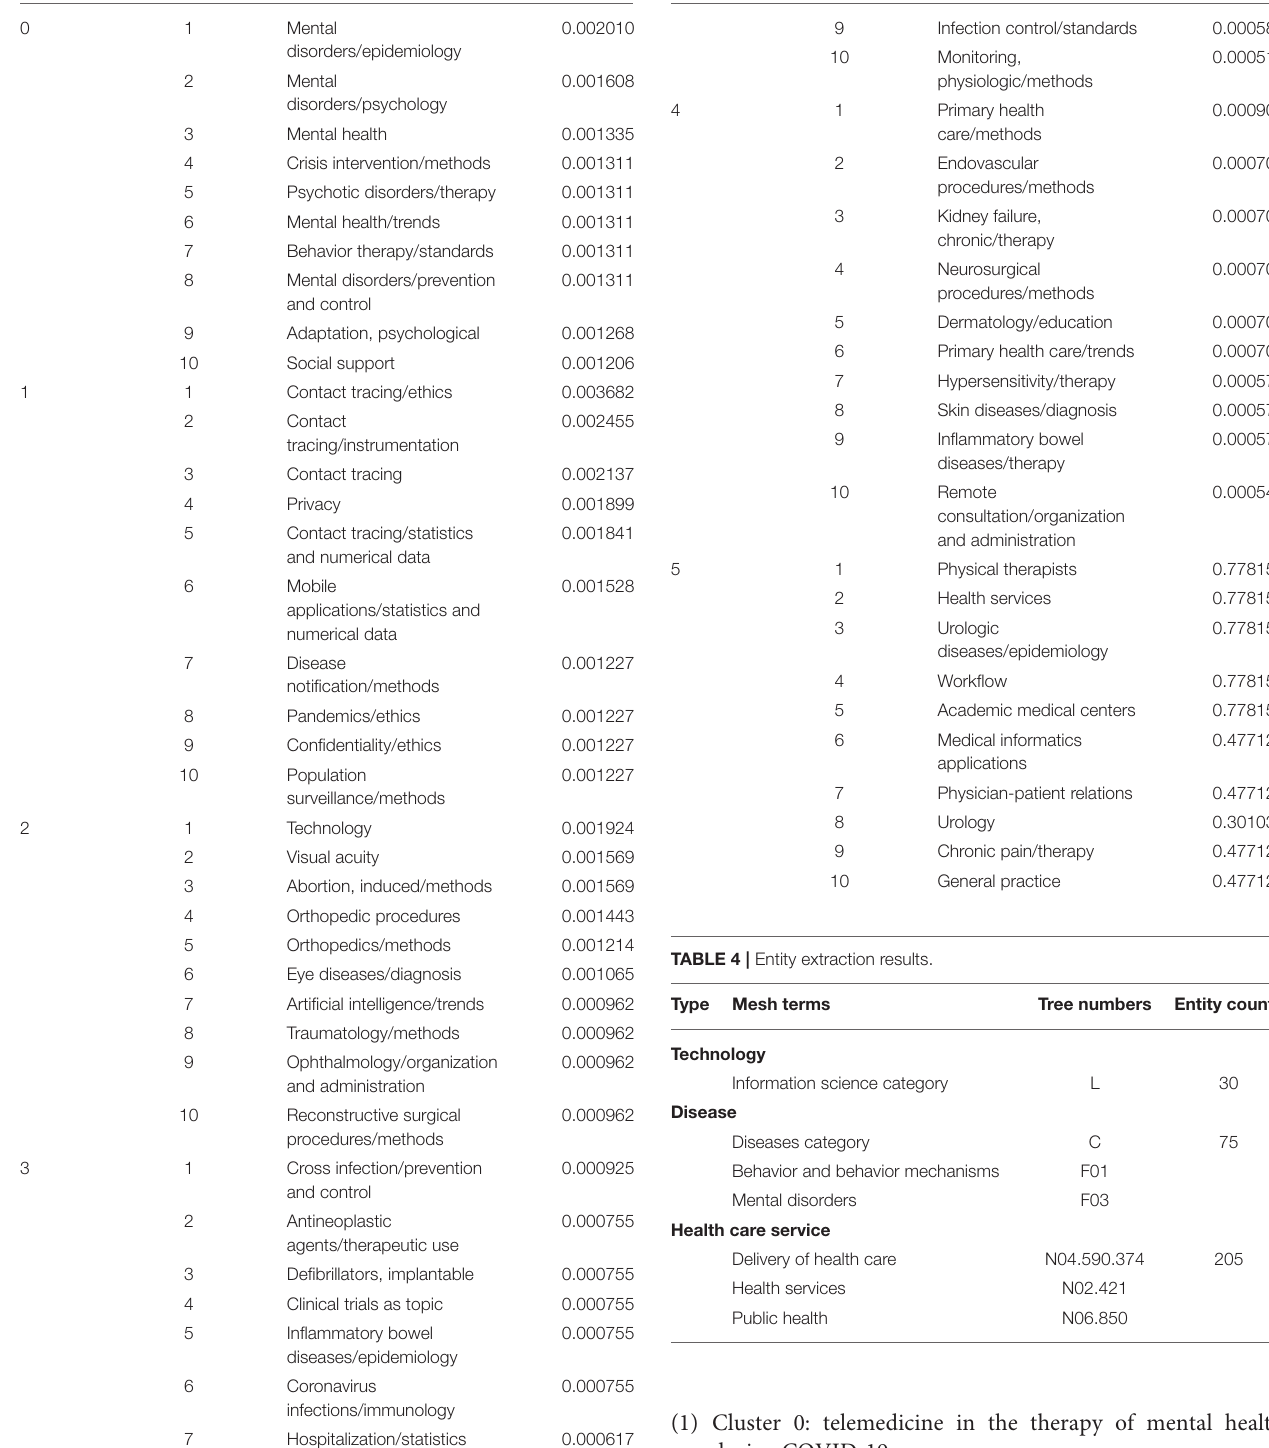
TABLE 3 | Continued Cluster Rank MAJR TF-IDF